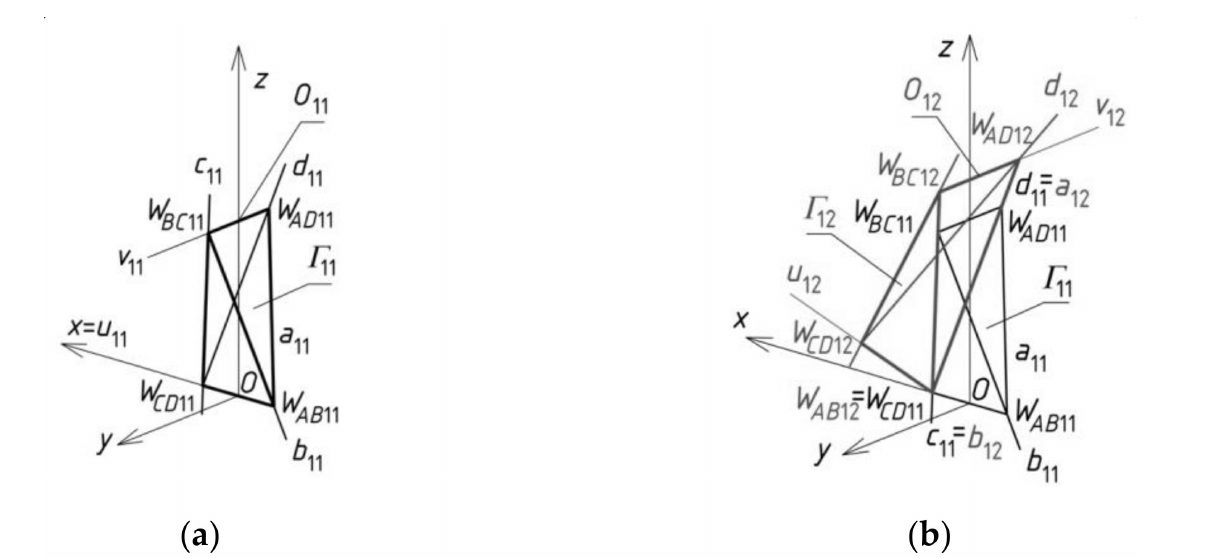
Figure 9. The results of two initial steps of the method’s algorithm used for creating Γ : ( a ) Γ 11 ; ( b ) Γ 12